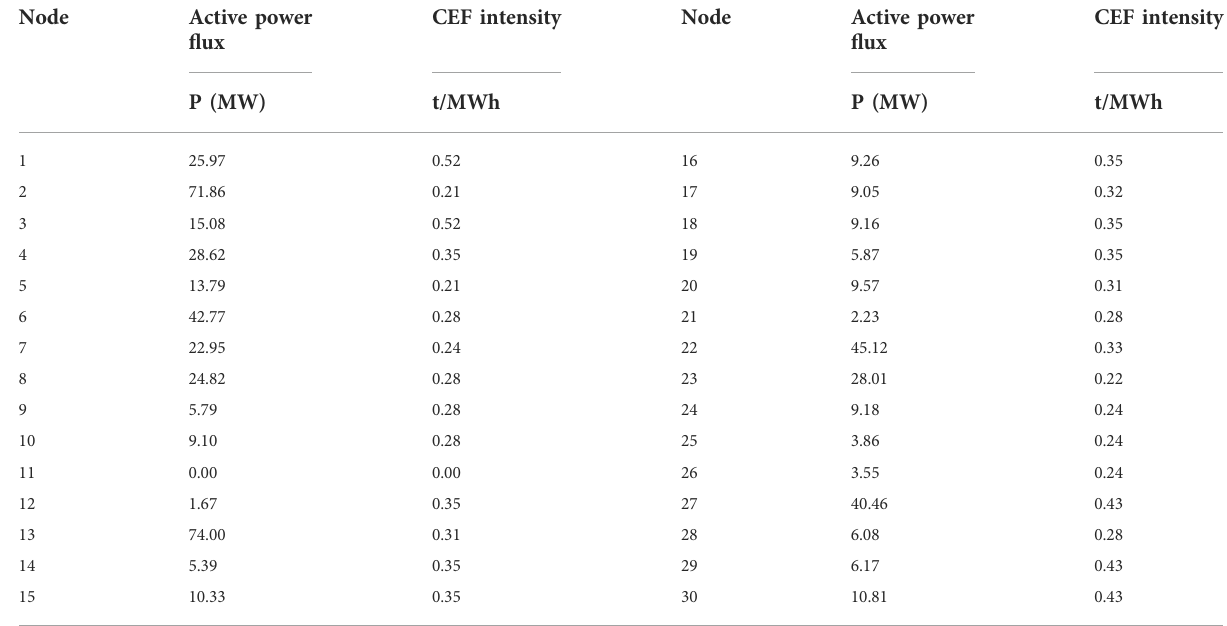
TABLE 6 The calculation results of CEI and active fl ux.